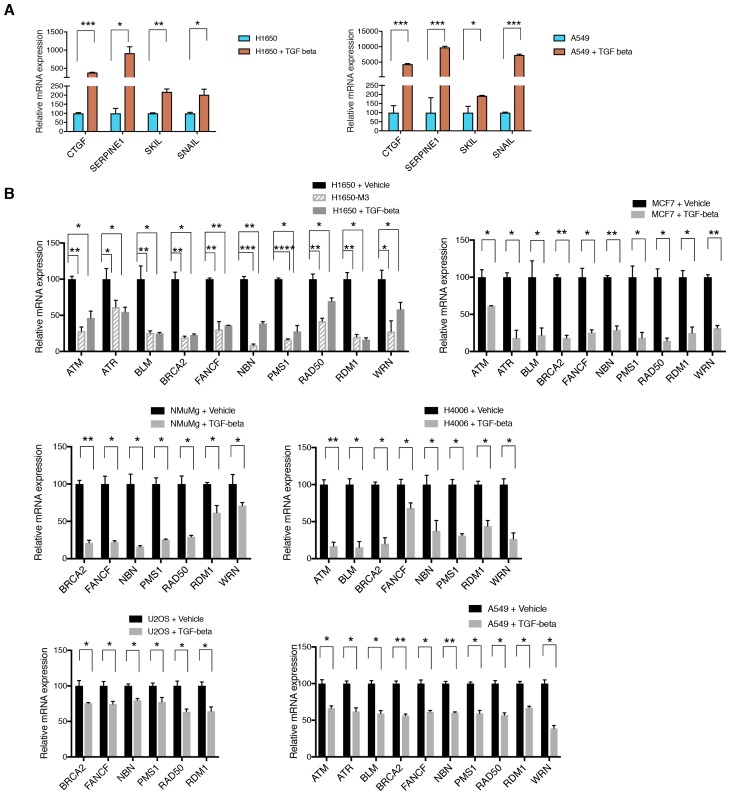
Active TGF-β signaling control the expression of multiple HDR genes.(A) TGF-β signature target genes measured by SYBR-green-based RT-qPCR in H1650 and A549 upon treating the cells with TGF-β for 9 hr. mRNA expression was quantified by RT-qPCR. Each bar represents the mean ± SD of three replicates from three independent experiments and represents mRNA expression of the indicated gene. p-value *<0.05, **<0.005 , ***<0.0005, paired t-test. (B) mRNA expression analysis of indicated HDR genes in TGF-β-treated cells relative to vehicle control in the indicated cell lines. mRNA expression was quantified by SYBR-green-based RT-qPCR. Each bar represents the mean ± SD of three replicates from two independent experiments (n = 6), normalized to respective GAPDH mRNA expression. Cells were treated for 9 hr with TGF-β (1 ng/ml each of TGF-β1 and TGF-β2). p-value *<0.05, **<0.005 ***<0.0005, paired t-test.